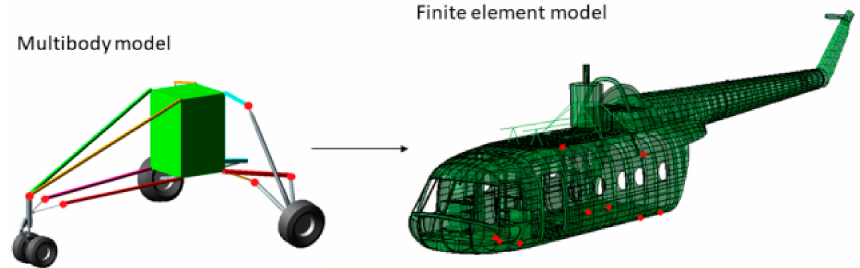
Figure 13. The displacement control approach schematics. Red dots represent the control points, i.e., the landing gear-fuselage attachment